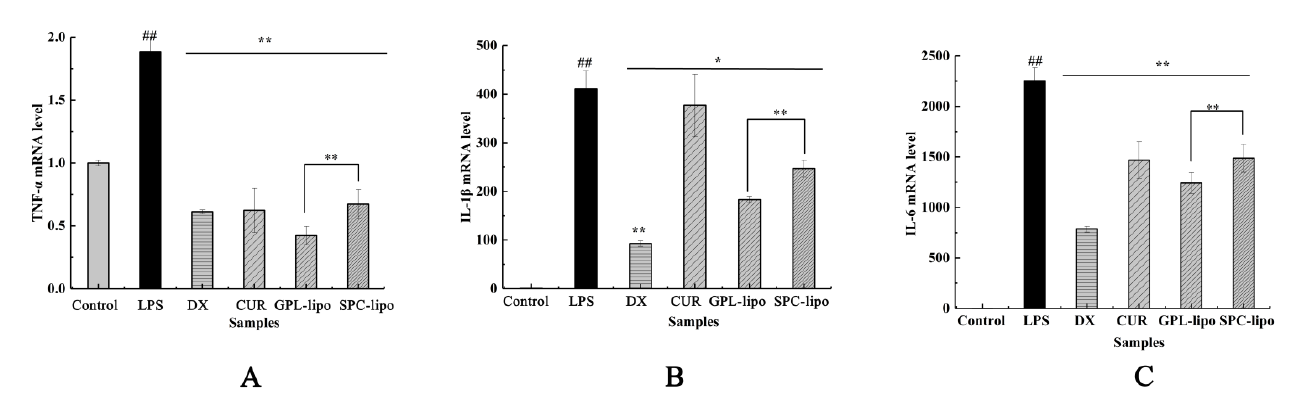
Figure 6. Effects of GPL-lipo and SPC-lipo on the expression of tumor necrosis factor (TNF)- α ( A ), interleukin 1 β (IL-1 β ) ( B ), and interleukin 6 (IL-6) ( C ) in RAW246.7 cells. Data are expressed as mean ± SD ( n = 4) and multiple comparisons were done using one-way ANOVA analysis.; ## , p < 0.01 versus the control group; *, p < 0.05; **, p < 0.01 versus the LPS group.